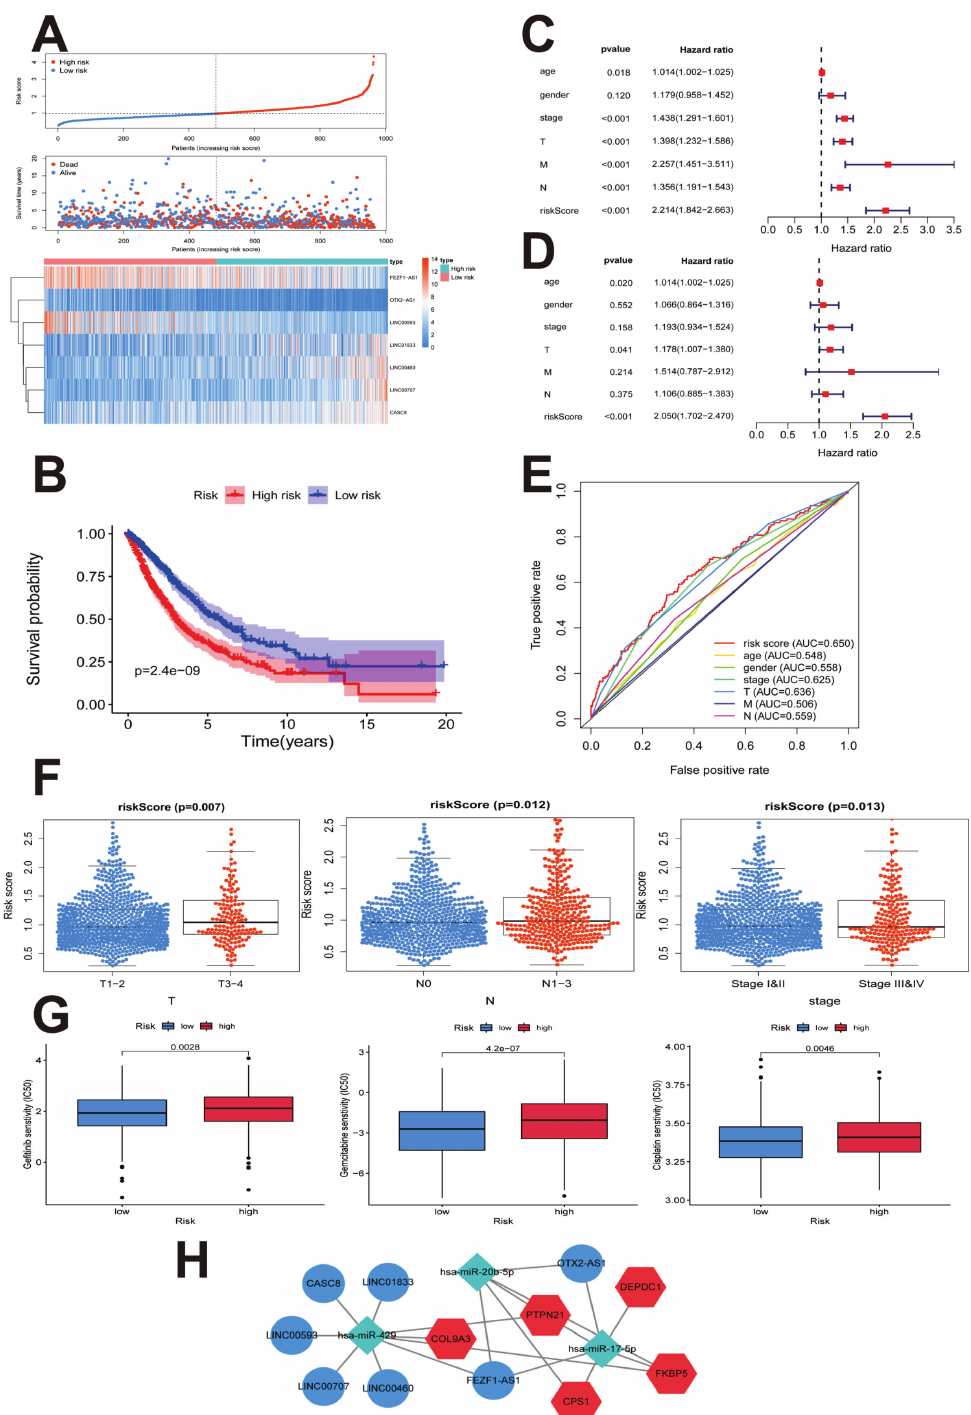
Fig 8. Construction of the seven-lncRNA-based prognostic model from ceRNA network to predict resistance to cancer drugs. (A) Risk score distribution in patients with NSCLC, survival status in different groups, and heatmap of the expression of seven lncRNAs. (B) K–M plot represents that patients in the high-risk group had significantly shorter OS than those in the low-risk group. (C) Forest plot of univariate Cox regression analysis showed the association between risk factors and survival of NSCLC. (D) Forest plot of multivariate Cox regression analysis showing that the seven-lncRNA signature was an independent predictor of prognosis in NSCLC. (E) ROC curve showing that the AUC of seven-lncRNA